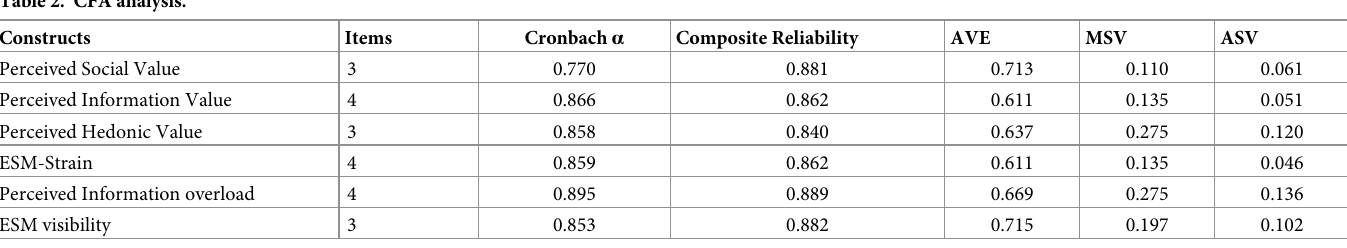
Table 2. CFA analysis.